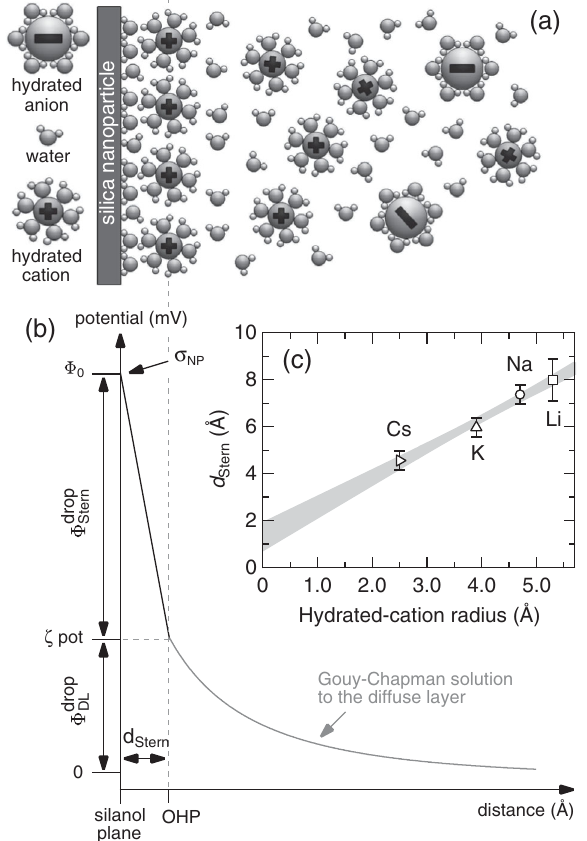
FIG. 5. Gouy-Chapman-Stern model of the electrical double layer. (a) The structure of the electrical double layer takes the form of a charged silanol plane and an outer Helmholtz plane (OHP), which represents the distance of closest approach of ions [17]. A diffuse layer of hydrated ions sits outside the OHP, screening the net surface charge over a characteristic Debye length. (b) The surface potential is given by the potential drop across the Stern layer (bounded by the OHP) and the potential across the diffuse layer, the latter being given by the zeta potential. (c) Thickness of the Stern layer [ d , from Eq. (5)] Stern as a function of hydrated cation radius, taking the reference potential Φ NaCl 0 to be − 385 (cid:2) 20 mV, as determined from Fig. 3. The linear fit has a y intercept at 1 . 4 (cid:2) 0 . 6